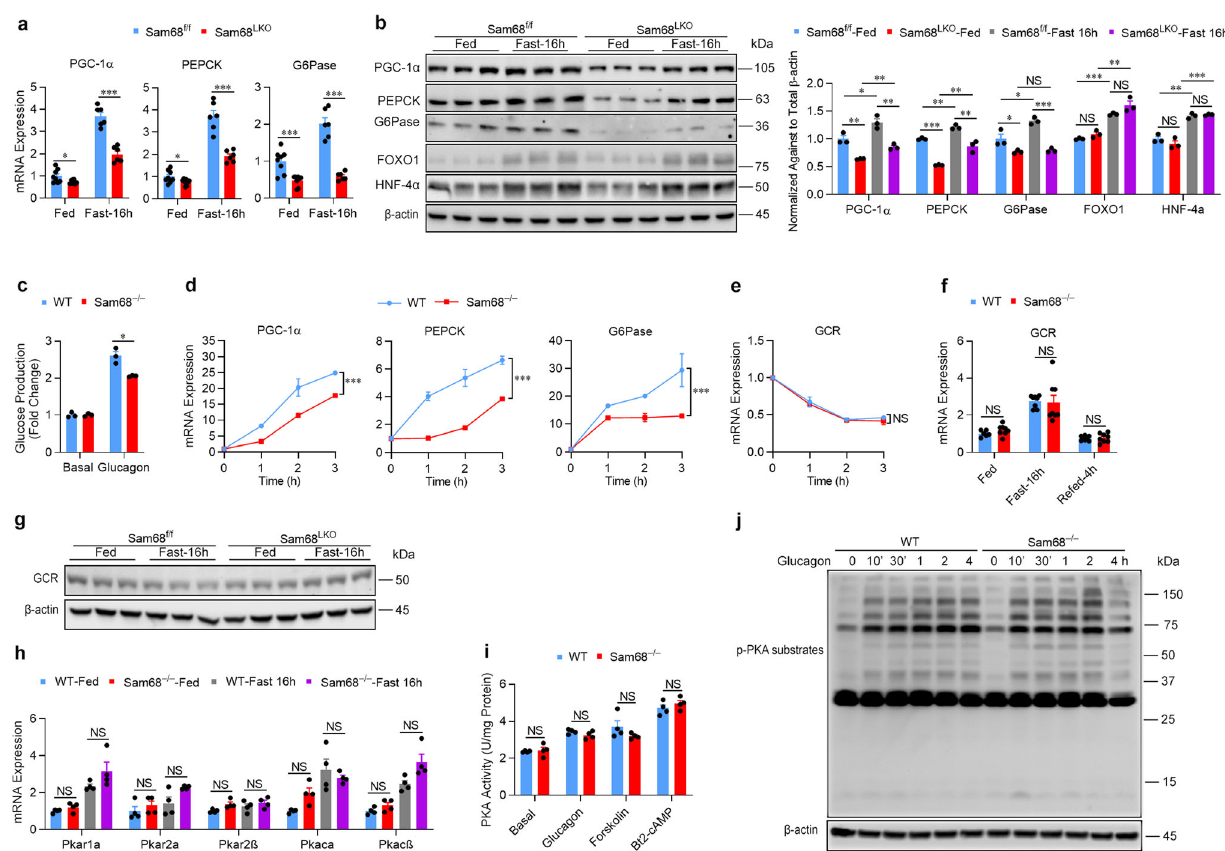
Fig. 2 Hepatic Sam68 de fi ciency reduces glucagon signaling and gluconeogenic gene expression. a mRNA and b protein expression of gluconeogenic genes were evaluated via qRT-PCR and Western blotting, respectively, in the livers of Sam68 LKO and Sam68 f/f mice under feeding conditions and after the animals had been fasted for 16 h ( a ; Fed, n = 8; Fast-16 h, n = 6. b ; n = 3). c Glucose production was measured in WT and Sam68 − / − primary hepatocytes that had been cultured with (Glucagon) or without (Basal) glucagon (100 nM) for 4 h ( n = 3). d mRNA expression of gluconeogenic genes was measured in WT and Sam68 − / − primary hepatocytes after treatment with glucagon for 0 − 3 h ( n = 3). mRNA expression of the glucagon receptor (GCR) was evaluated ( e ) in WT and Sam68 − / − primary hepatocytes after treatment with glucagon for 0 − 3 h ( n = 3) and ( f ) in the livers of WT and Sam68 − / − mice under feeding conditions (WT, n = 6; Sam68 − / − , n = 8), after fasting the animals for 16 h (WT, n = 8; Sam68 − / − , n = 8), and after 16 h of fasting followed by 4 h of refeeding (WT, n = 8; Sam68 − / − , n = 8). g Protein expression of GCR was assessed by Western blotting ( n = 3). h mRNA expression of PKA subunits was evaluated in the livers of WT and Sam68 − / − mice under feeding conditions or after 16 h of fasting ( n = 4). i PKA activity was measured in WT and Sam68 − / − primary hepatocytes after treatment with PBS (basal), glucagon, forskolin (10 μ M), or Bt2-cAMP (100 μ M) for 30 min ( n = 4). j WT and Sam68 − / − primary hepatocytes were treated with glucagon for 0 − 30 min and for 1 − 4 h; then, protein levels of phosphorylated PKA substrates were evaluated. Data are expressed as mean ± s.e.m. * p < 0.05, ** p < 0.01, *** p < 0.001, NS, not signi fi cant (two-way ANOVA). “ n ” denotes